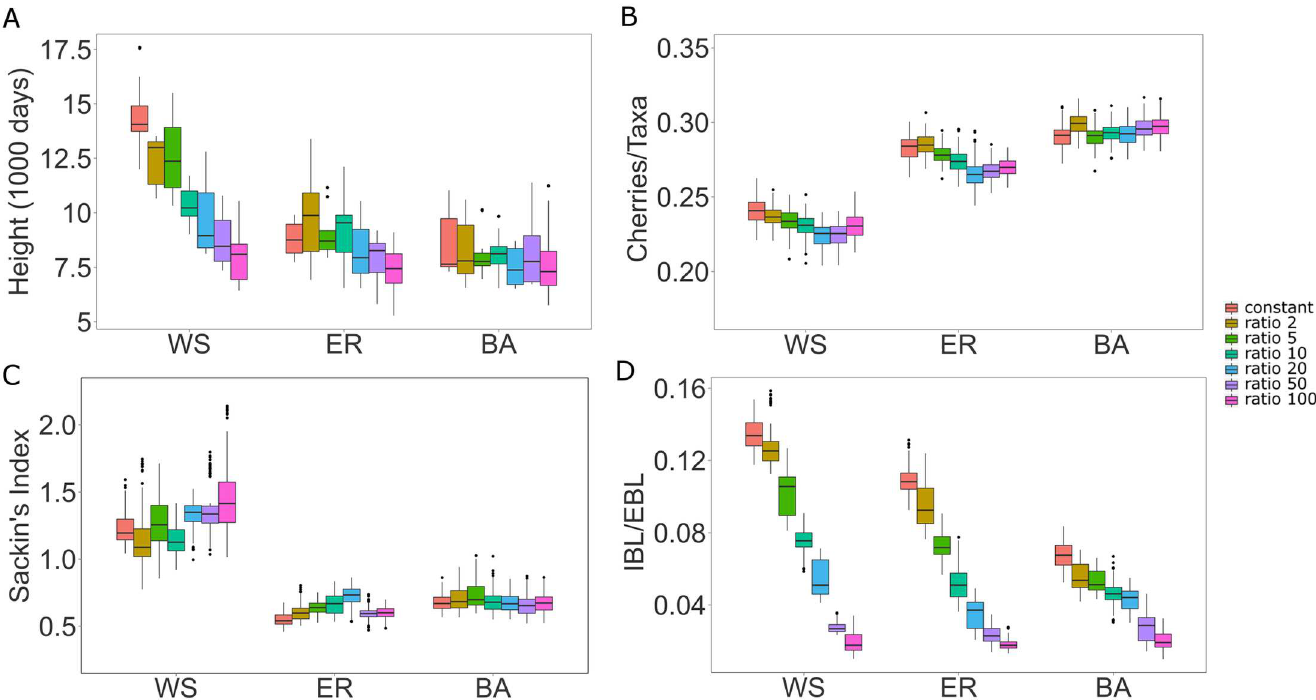
Fig 4. Box plots of tree statistics on virus genealogies under varying infectivity profiles. Tree height (A), number of cherries per taxa (B), Sackin’s index (C), mean internal/external branchlengths ratio (D). Box plots limits are as in Fig 3.